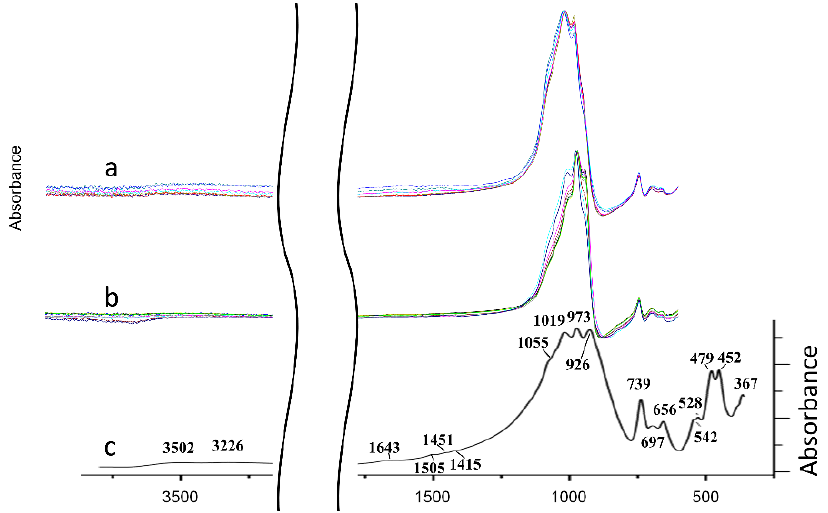
Figure 6. Kramers–Kronig-transformed attenuated total reflectance spectra obtained from the pol- ished surfaces, perpendicular ( a ) and parallel ( b ) to the three-fold axes of the same crystal and powder infrared absorption spectrum of EGMs ( c ) from Odikhincha alkaline